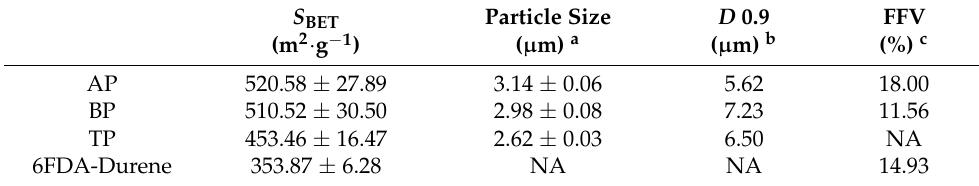
Figure 1. ( a ) SEM; and ( b ) high-resolution TEM of AP. Table 1. Porosity property, particle size, and FFV of AP, BP, TP, and 6FDA-Durene.